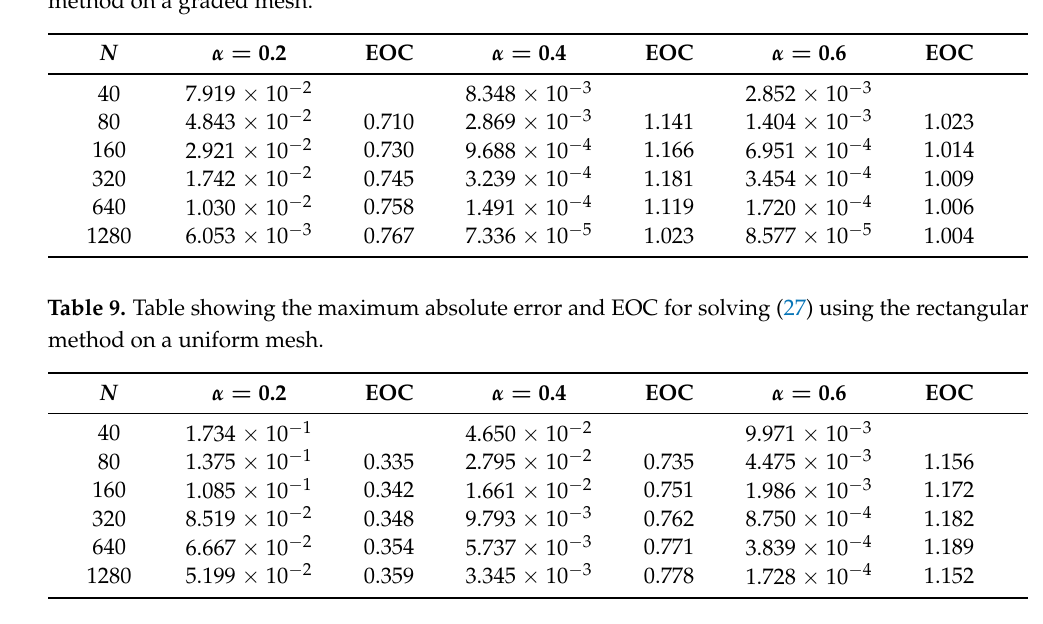
Table 8. Table showing the maximum absolute error and EOC for solving (27) using the rectangular method on a graded mesh.